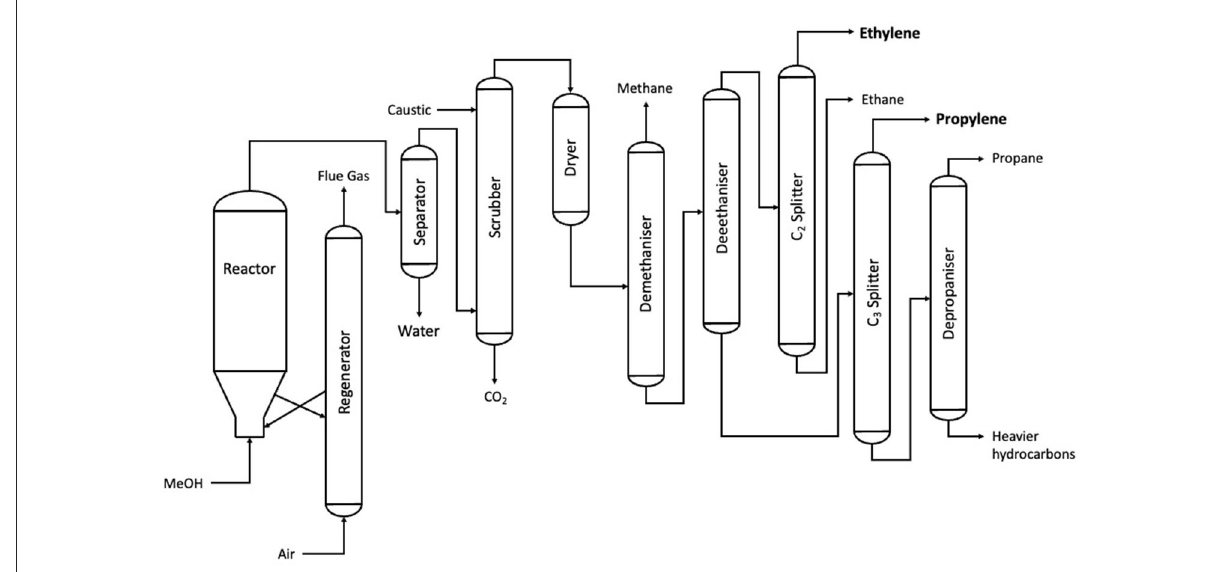
FIGURE7 A process flow diagram for the UOP MTO process (after Keil, 1999).